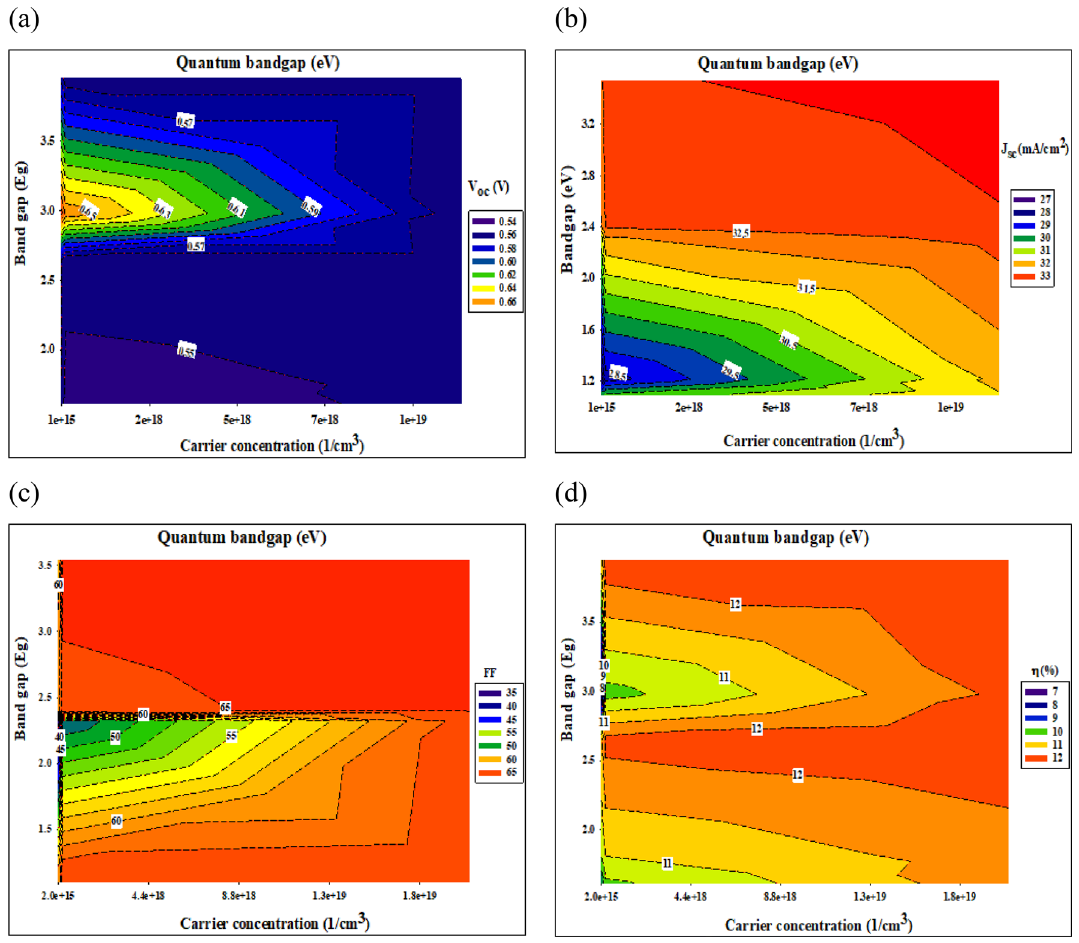
Figure 10. Photovoltaic performance parameters at quantum